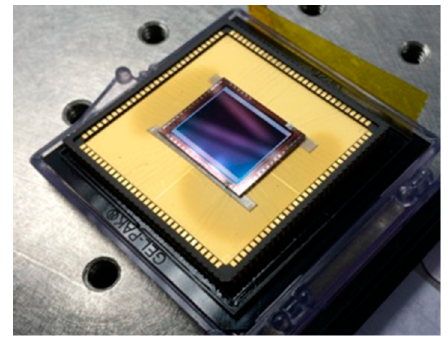
Figure A1. APDIS IR Focal Plane Array.